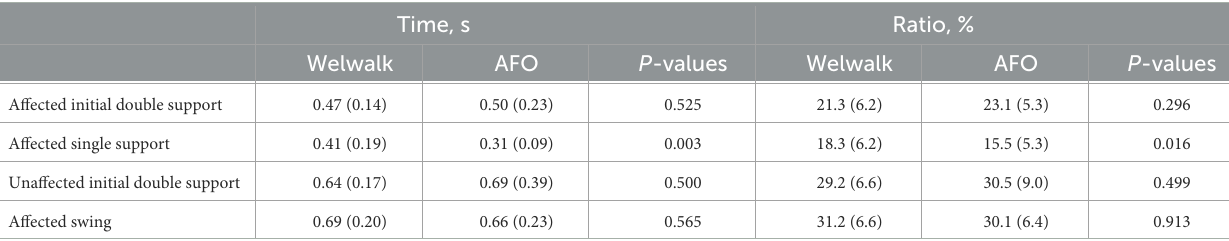
TABLE 4 Temporal parameters of the gait